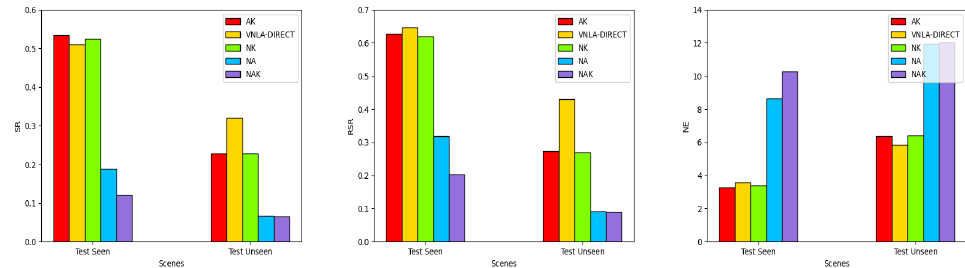
Figure 5. The comparison results of different ablation baselines on VNLA. SR (%), RSR (%), and NE (m) are reported for both Test Seen and Test Unseen scenes. Apart from NE, a higher value indicates the better